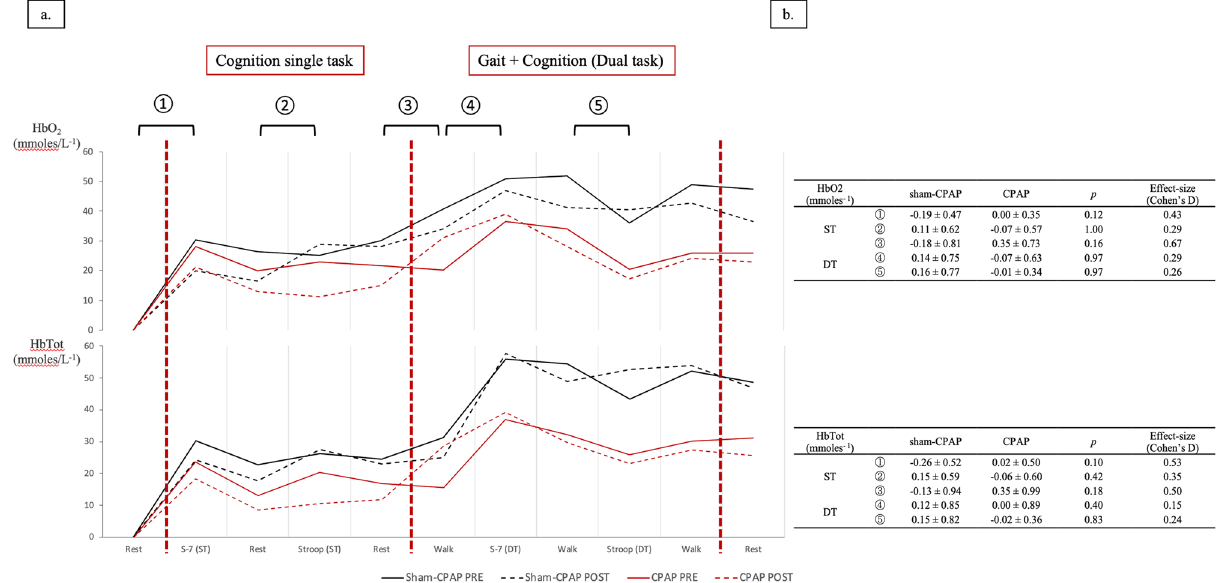
Figure 3. Evolution of prefrontal cortices Oxy[HbO2]- and Total[HbTot]-hemoglobin concentration assessed by functional Near Infrared Spectroscopy during the treadmill test. ( a ) Evolution of [HbO2] and [HbTot] (in mmoles −1 ) pre (continuous line) and post (dotted line) intervention for sham-CPAP (n = 11, represented in black) and CPAP (n = 6, represented in red) groups. Data are the measured mean values of [HbO2] and [HbTot] over the first 30-s of each task, averaged for left and right prefrontal cortices. To assess the evoked hemodynamic response, five activation indices were calculated as the difference in [HbO2] and [HbTot] between task and rest (in ST) or task and walk (in DT): ① S-7 ST; ② Stroop test ST; ③ Walk ST; ④ S-7 DT; ⑤ Stroop test DT. ( b ) Comparisons of delta pre-post intervention of [HbO2] and [HbTot] between sham-CPAP (n = 11) and CPAP (n = 6) groups. Data are mean ± 1 standard deviation. Analysis of data by Wilcoxon-Mann–Whitney test for tasks, ST single